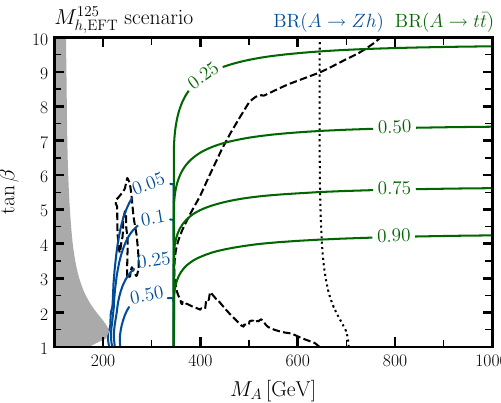
Z -boson and the light CP -even Higgs boson h ( blue ) and into a pair of top quarks ( green ). In each plot, the gray exclusion region and the ( ˜ χ) boundaries of the blue and the hatched exclusion regions (shown as h , EFT dashed and dotted black lines , respectively) of Fig.1 are also depicted